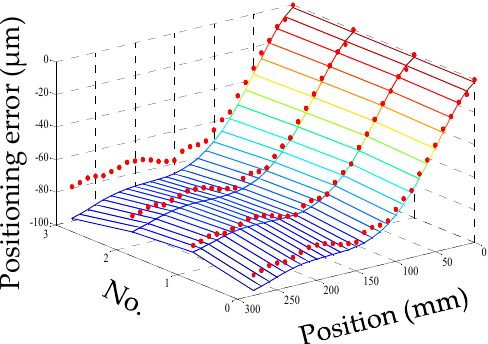
Figure 19. The prediction results of ANN model (measured positioning error marked with dots) in experiment II.